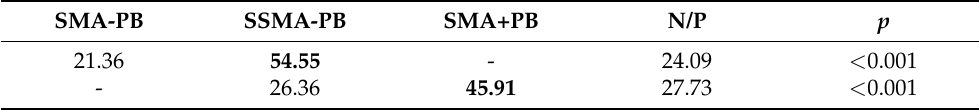
Table 2. Subjective preference scores (%) among SMA-PB, SSMA-PB, and SMA+PB systems on the test set, where N/P denotes “No Preference” and p means the p -value of t -test between two